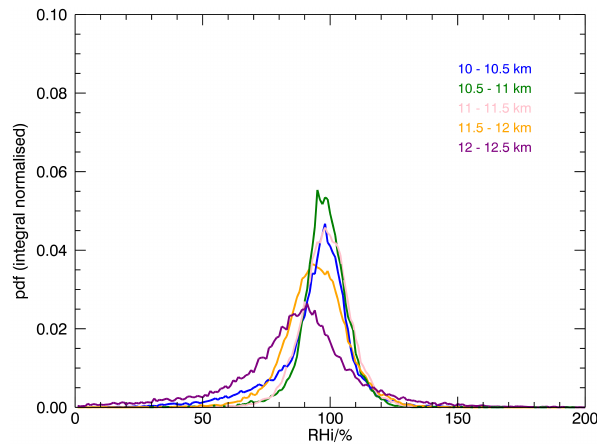
Figure 8. Frequency distribution of the relative humidity over ice inside the cirrus cloud shown in Figs. 3 and 7. The bin size of the histogram is 2%.